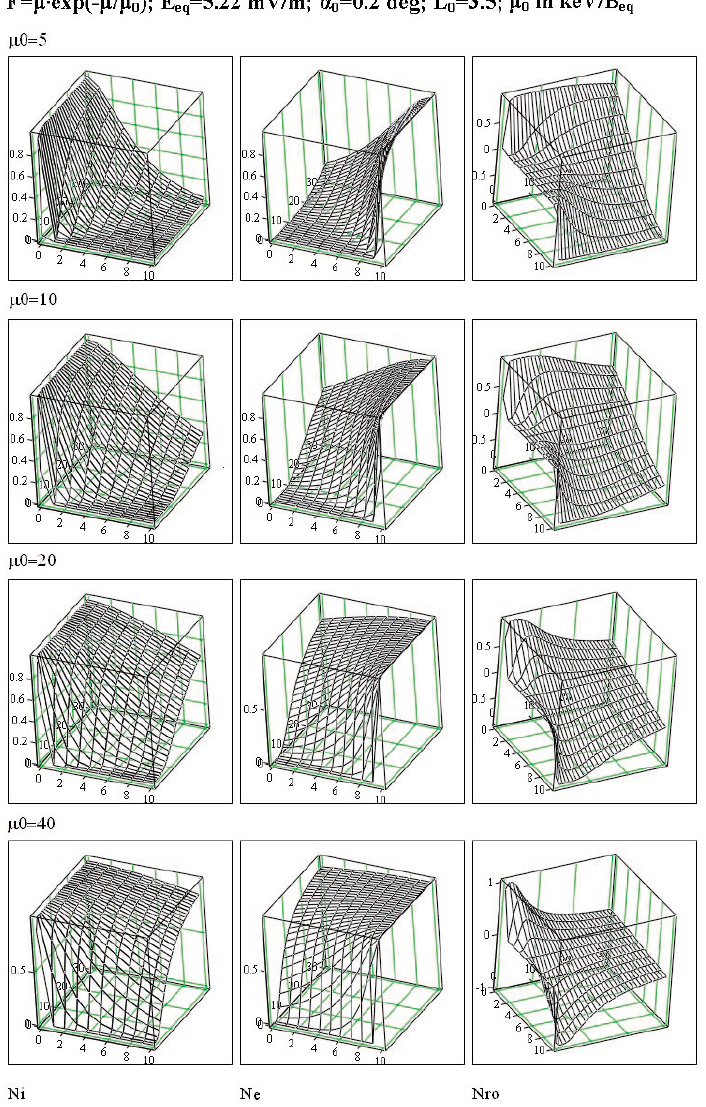
Fig. 3. Modelled space-time evolu- tion of the injected particles normal- ized density of ions N i (left column) and electrons N e , (central column), and the resulting normalized charge density N r 0 = N i − N e , (right column). They are presented as functions of the cross- PJ distance ‘ at the equatorial plane (in units of R E , from 0 to 0.3 at L ∼ 3 . 7), and the time j in units of 0.1h (i.e. from 0 to 3h) after the start of the quasi-steady stage of the PJ band. The rows are for 4 distribution functions with µ 0 = 5 , 10 , 20 and 40keV/ B eq ,